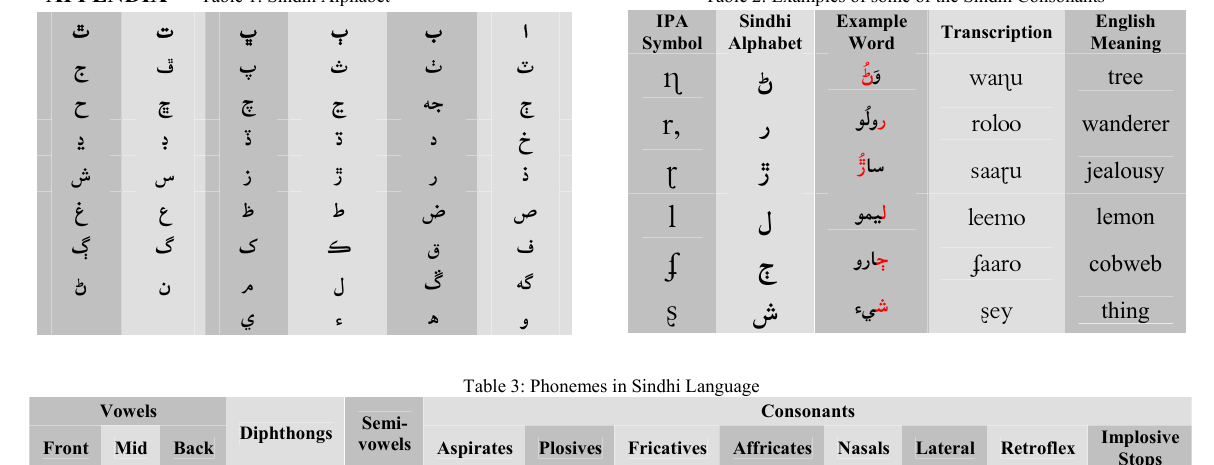
Table 1: Sindhi Alphabet Table 2: Examples of some of the Sindhi Consonants